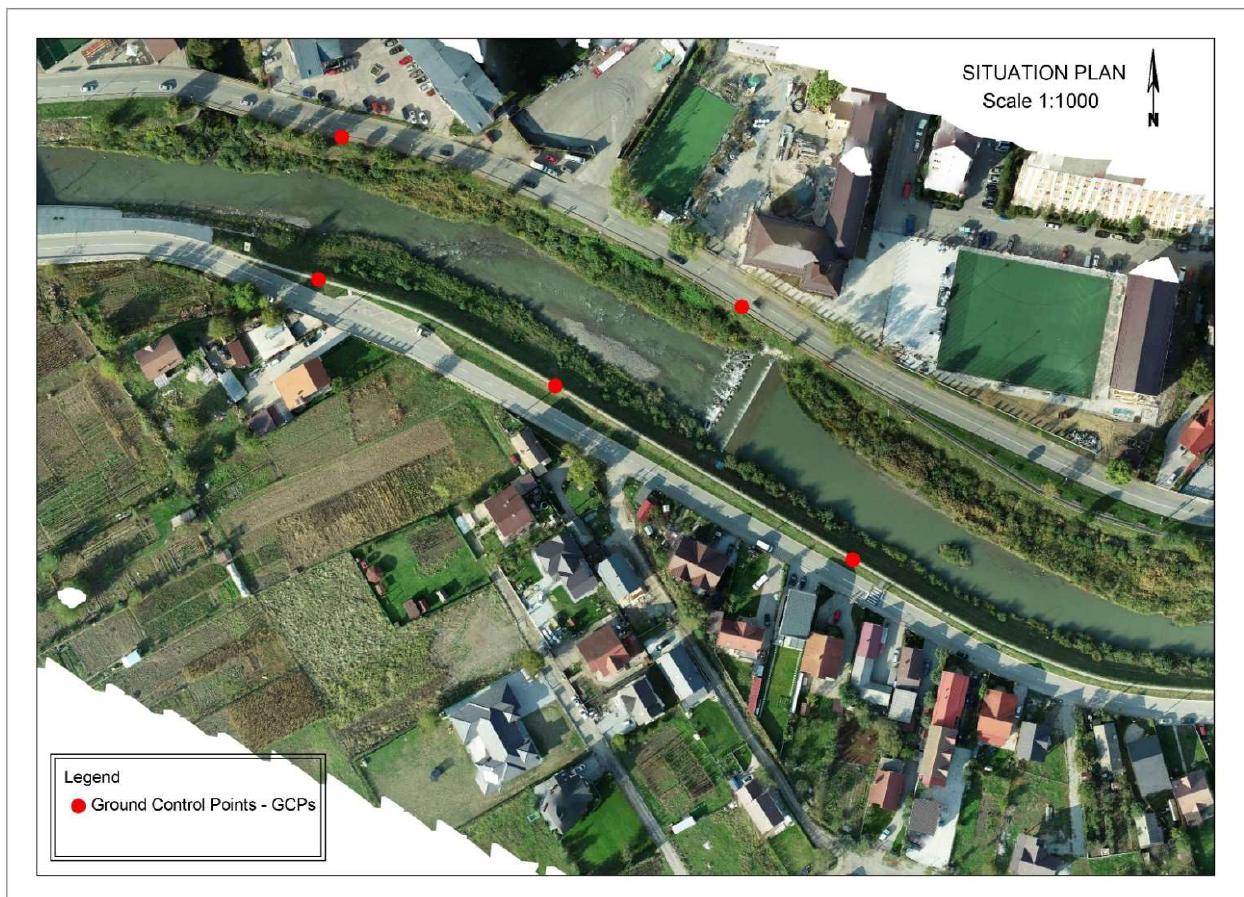
Figure 3. Representation on the orthophoto plane of the five ground control points (GCP); they were used for georeferencing the images.